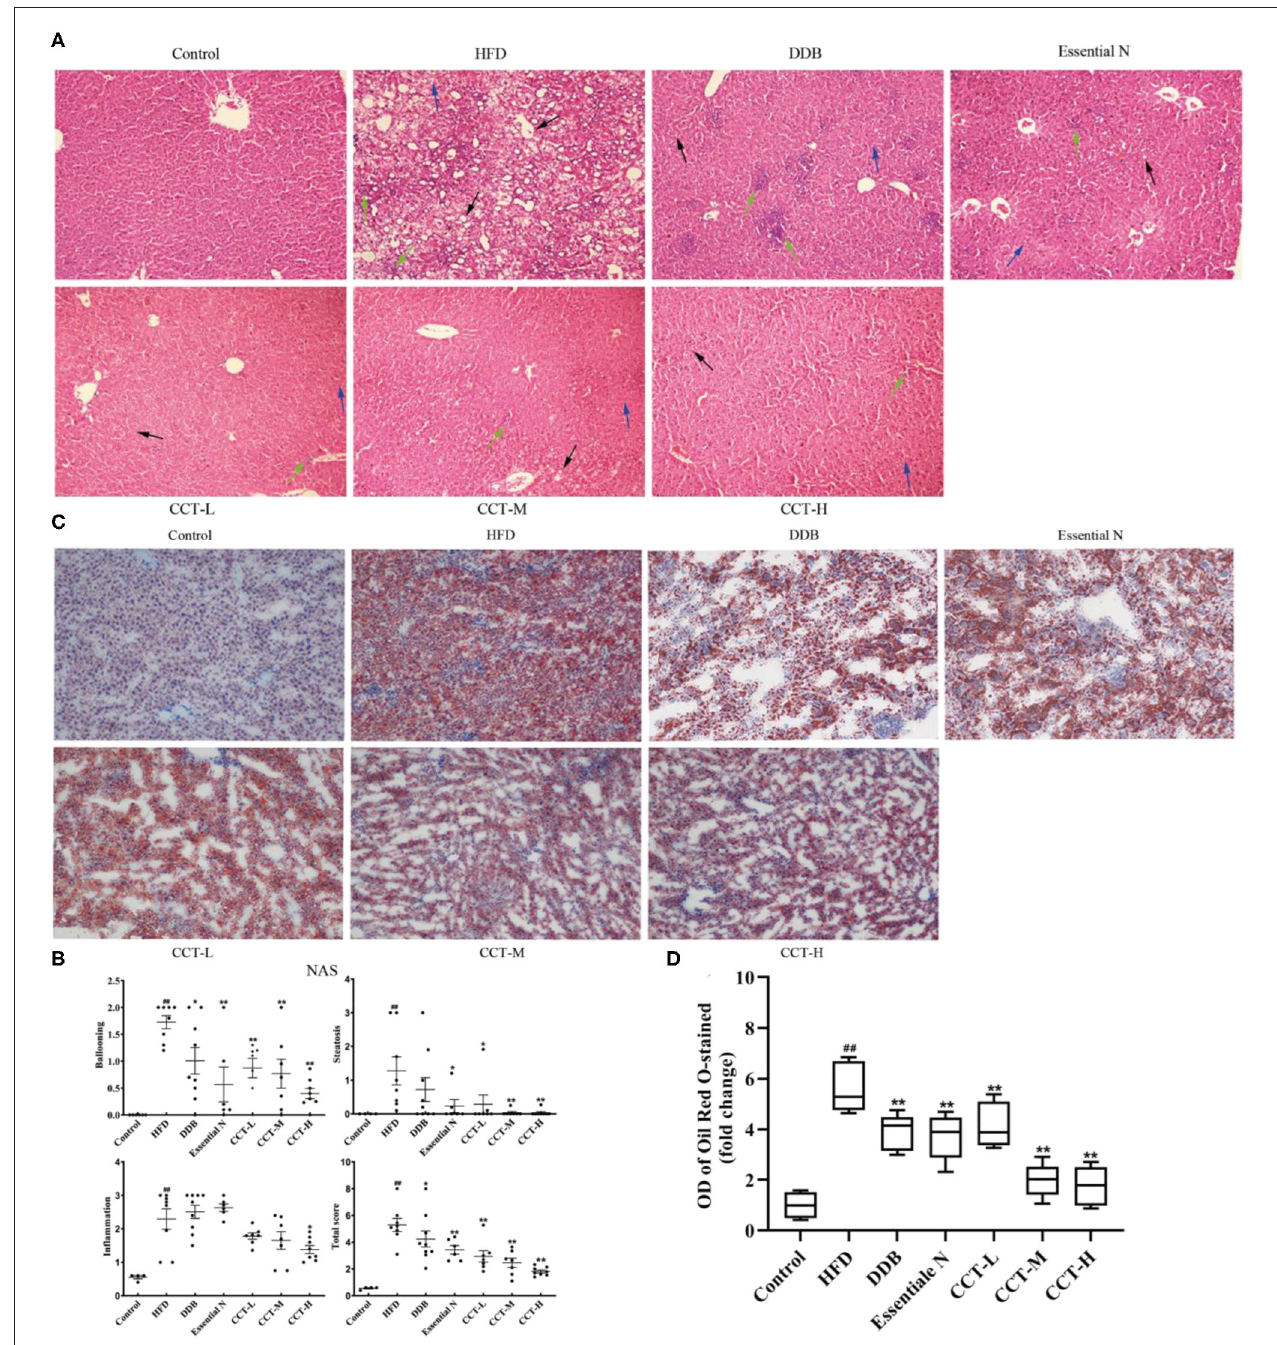
FIGURE 10 | Effects of CCT on liver histopathology. (A) Representative photomicrographs of HE staining ( × 200). The blue arrow represents steatosis, the green arrow represents lobular inflammation, the black arrow represents ballooning degeneration. (B) The NAS scores. (C) Representative photomicrographs of Oil Red O staining ( × 200). (D) The OD of Oil Red O staining(fold change). ## P < 0.01 vs. Control group; * P < 0.05, ** P < 0.01 vs. HFD